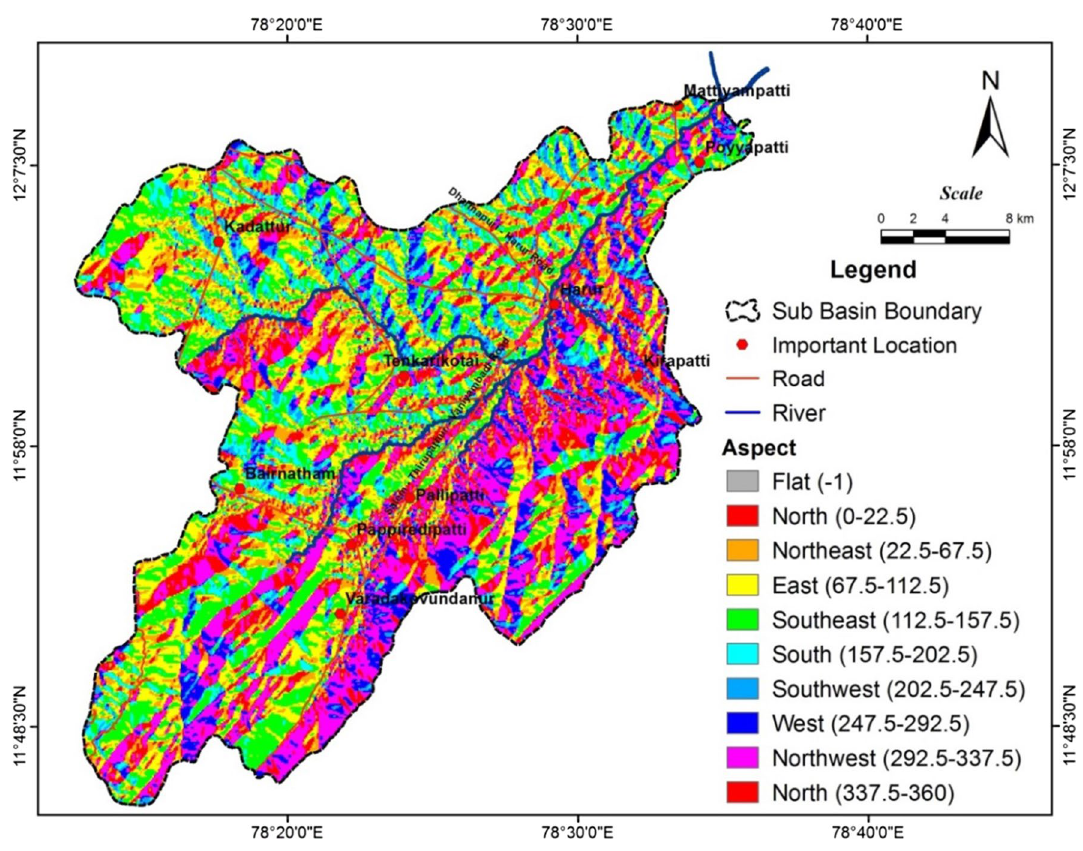
Fig. 10 Spatial variation of Aspect map delineate from DEM